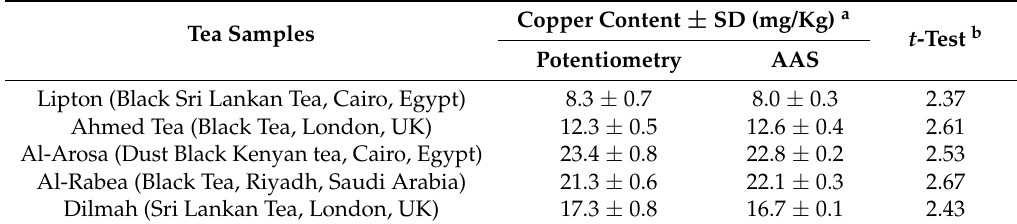
Table 4. Copper assessments in tea samples using solid contact Cu 2+